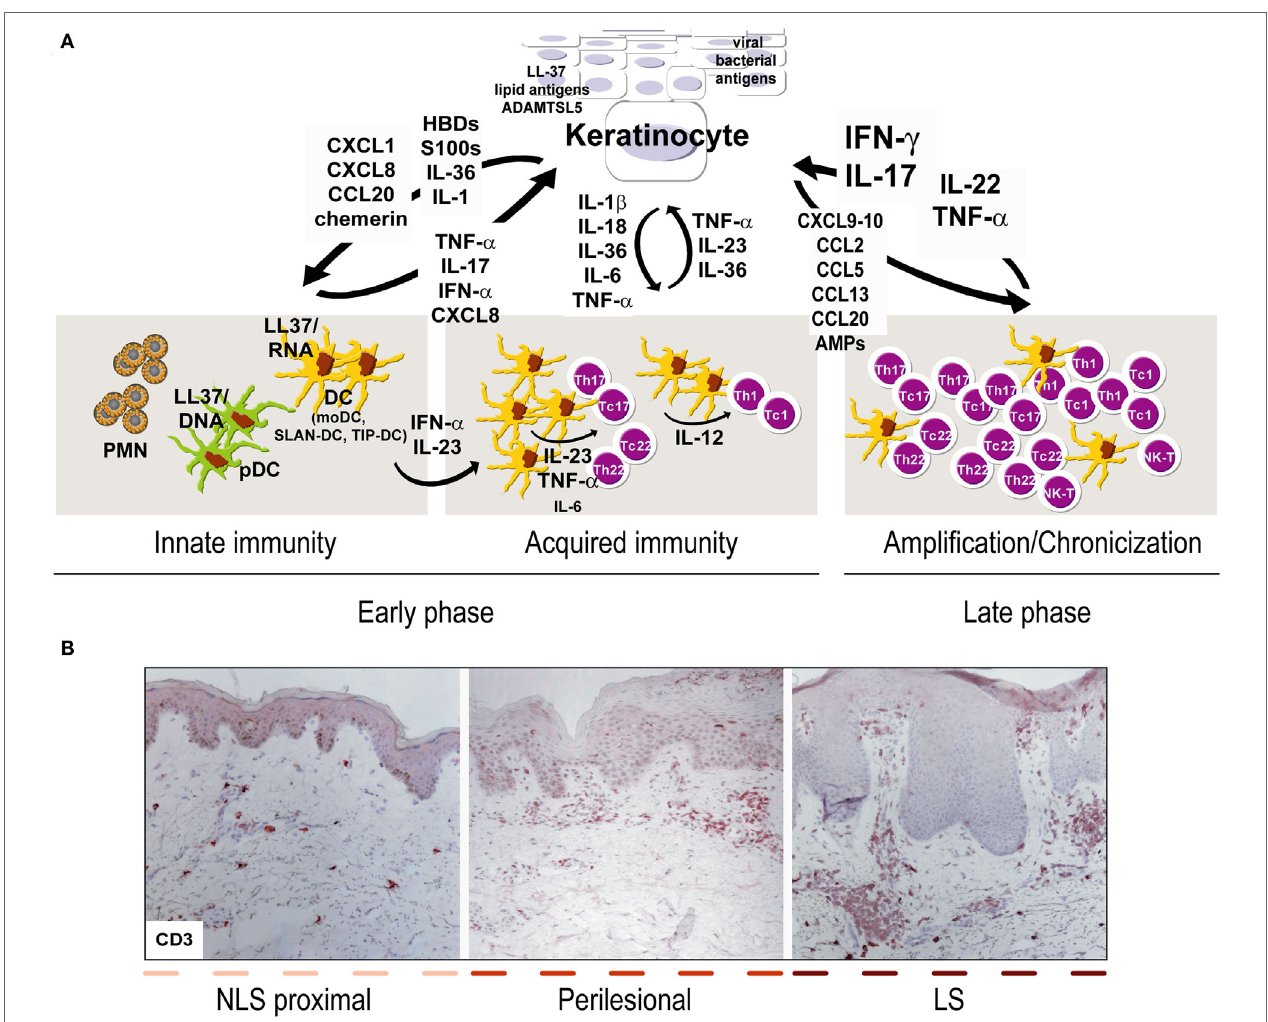
FigURe 1 | Aberrant interplay of keratinocytes and immune cells in psoriasis. (A) Early upstream events in psoriasis include induction of innate immunity pathways and acquired responses, and keratinocytes represent the “key responding” skin cells by producing trigger factors, including LL37/nucleic acid complexes, lipid antigens, and ADAMTSL5, as well as pathogens of viral or bacterial origin. During this initial phase, keratinocytes also produce antimicrobial peptides (AMP), such as β -defensins (HBD) and S100 proteins, together with chemokines and cytokines of IL-1 family. Among AMP, LL37 activates plasmacytoid dendritic cells and myeloid DC (mDC), which routinely patrol uninvolved psoriatic skin, in particular, non-lesional (NLS) skin proximal to lesions, with consequent beginning of the adaptive immune phase. In early phase, SLAN-DC and TIP-DC, highly producing TNF- α , are also present. Hence, DC drive expansion of T lymphocytes, mostly Th17 and Th22 in the beginning and type-1 interferon (IFN)- γ -producing T cells, especially during the chronic phase. During acquired immunity phase, keratinocytes influence DC immune functions by producing cytokines derived from inflammasome pathway, and IL-36. T-cell infiltrate present during late/chronic phase of psoriasis establishes a cytokine milieu, mainly represented by IFN- γ , TNF- α , IL-17, IL-22, which dictates specific and pathogenic gene signatures in keratinocytes, which, thus, overexpress a number of inflammatory mediators. In parallel, under the influence of cytokines, in particular, IL-22 and IL-17, keratinocytes hyperproliferate and show altered differentiative programs. During the amplification/chronicization phase of the disease, unceasing cross-talk between keratinocytes and immune cells further amplifies inflammation and hyperplasia. (B) Both early and late phases of psoriasis can be found within the same psoriatic plaque, being it comprehensive of LS, perilesional and adjacent NLS areas, with markers of chronic inflammation (i.e., CD3 + T accumulation in the dermis) predominantly present in LS skin [CD3 stainings have been retrieved from Ref.